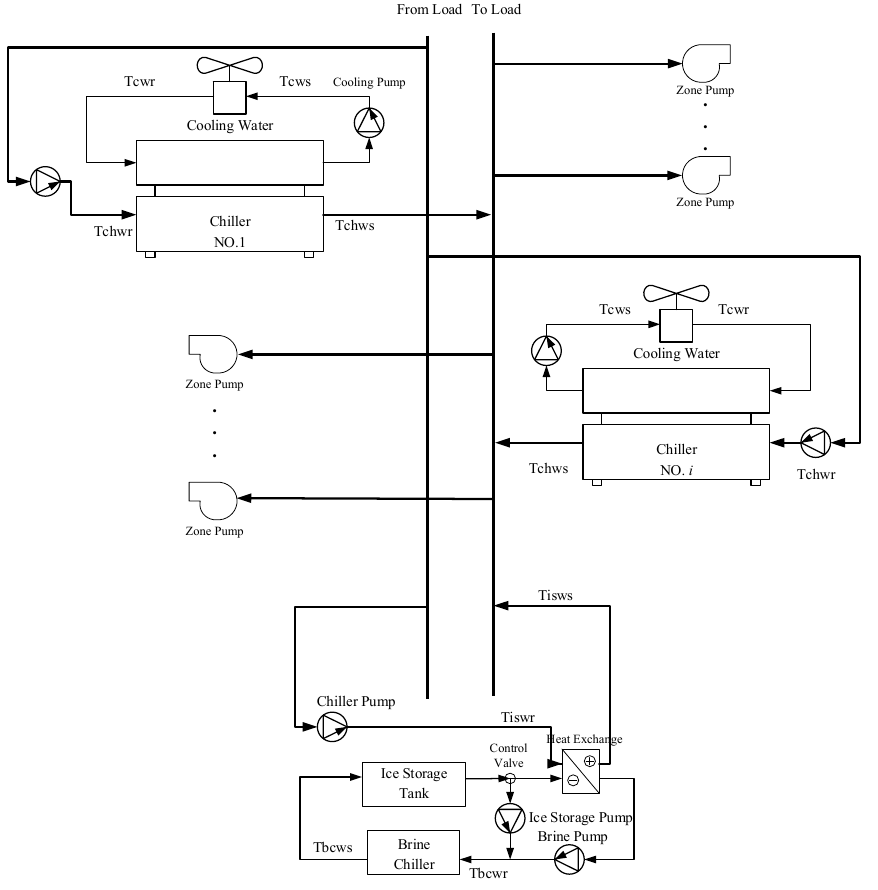
Figure 1. Ice storage air ‐ conditioning system.